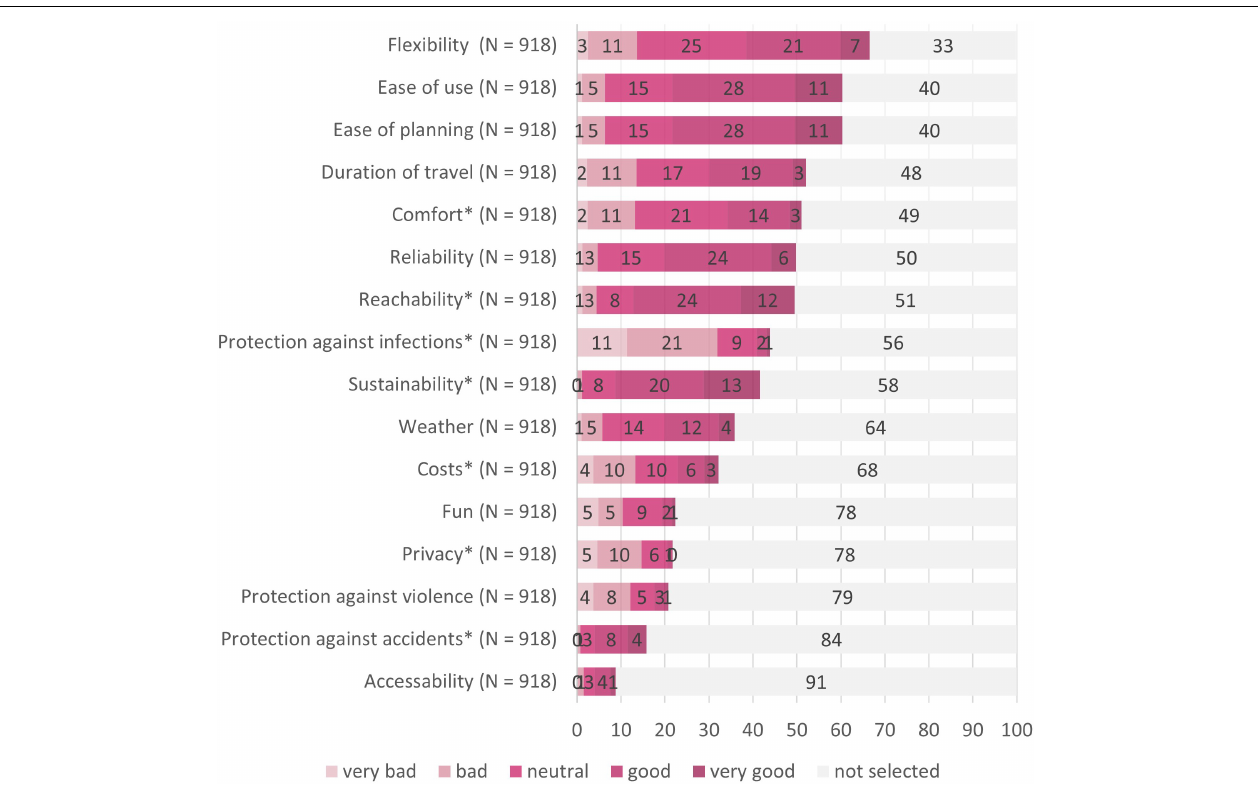
FIGURE 8 | Evaluation of public transport in regards to the importance of different criteria. N = 918; Prot. scr., protective screens. Numbers on the bars represent percentages. *Indicates significant differences ( p < 0.003) between the target groups in selecting this criterion.